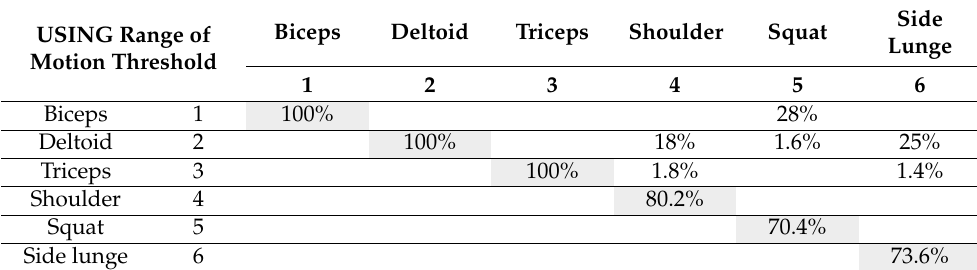
Table 1. The matrix fusion of the range of motion threshold